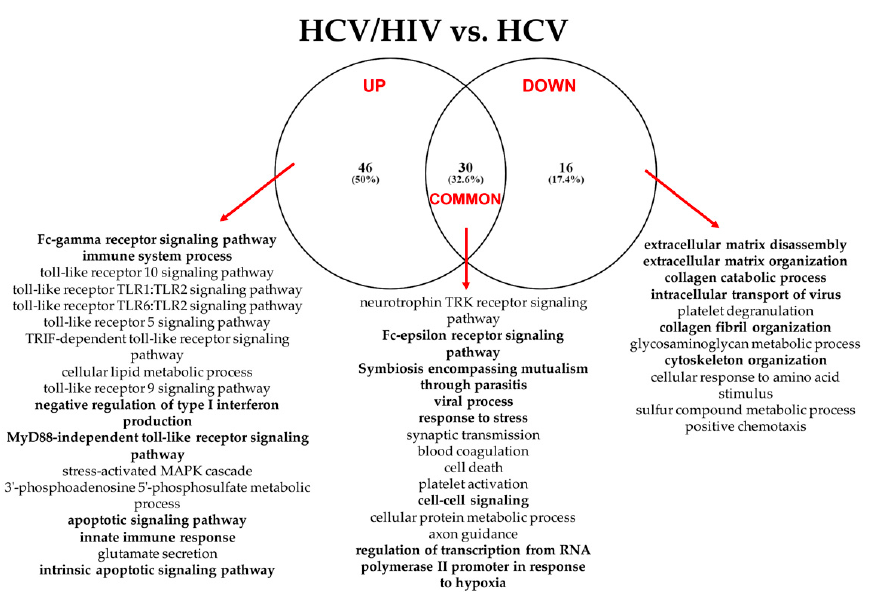
Figure 7. Summary of the “Gene Ontology-Biological Process” enriched functional terms associated with the predicted gene targets of the miRNAs differentially expressed between LB obtained from HCV/HIV co-infected patients vs. HCV mono-infected patients. Some of the most relevant biological processes are shown; the complete lists of enriched terms are available in Supplementary Table S10A.